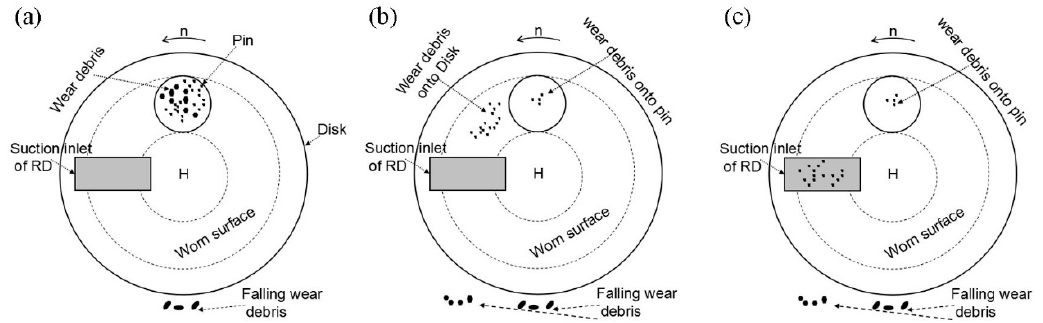
Figure 9. Behavior of wear debris when the RD was used. ( a ) Formation-absorption; ( b ) movement accompanying the disk; and, ( c ) removal.